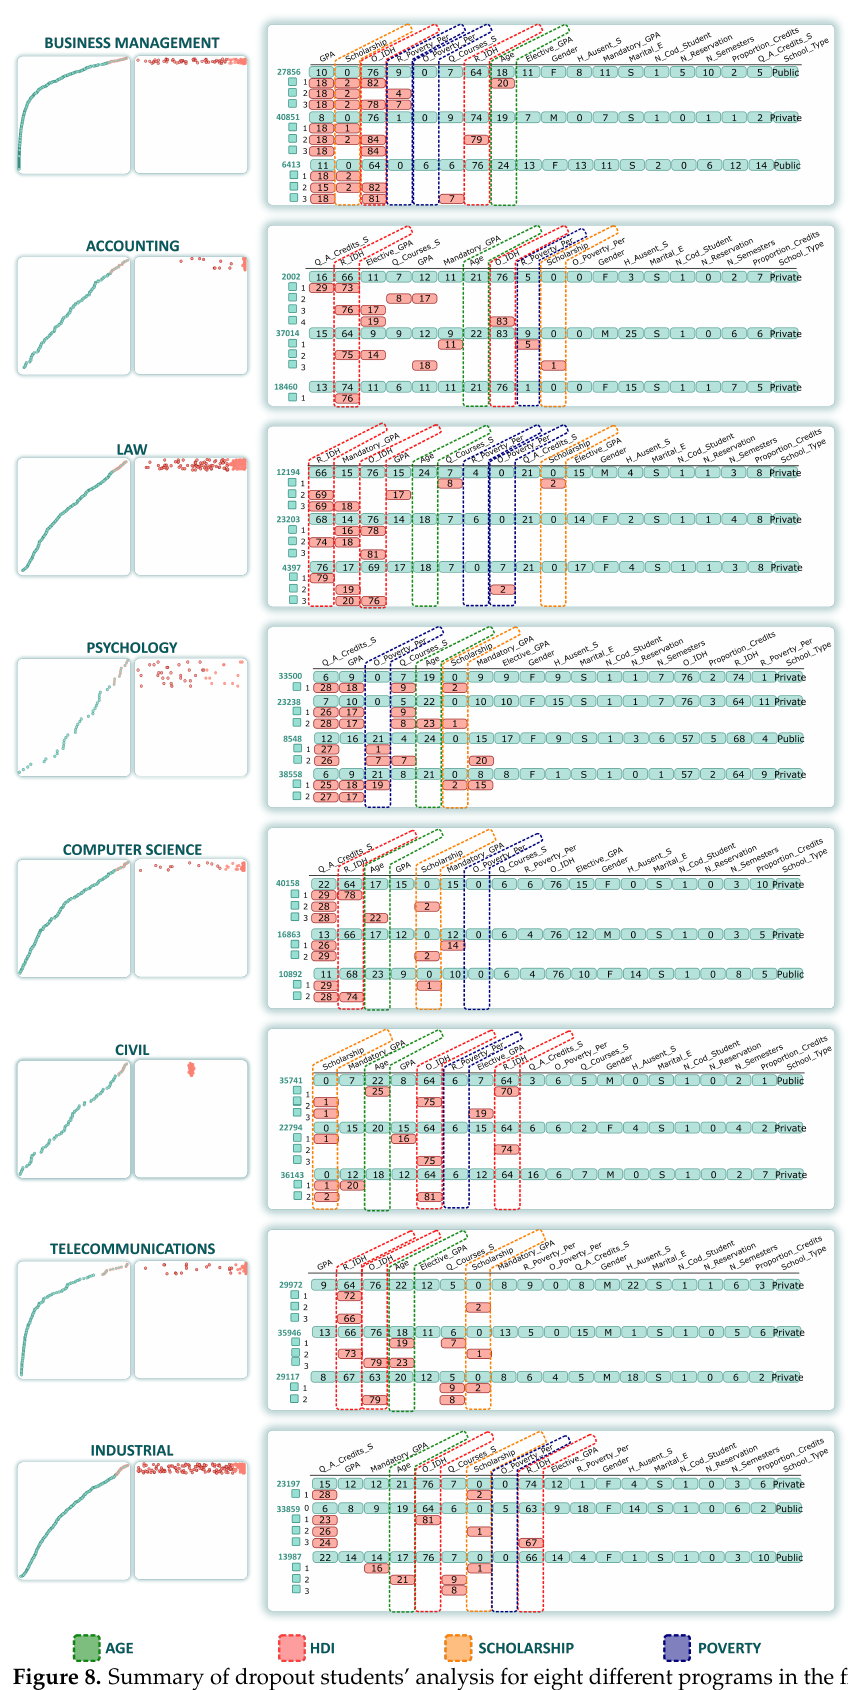
Figure 8. Summary of dropout students’ analysis for eight different programs in the first semester of the university. Some variables have a higher influence on their